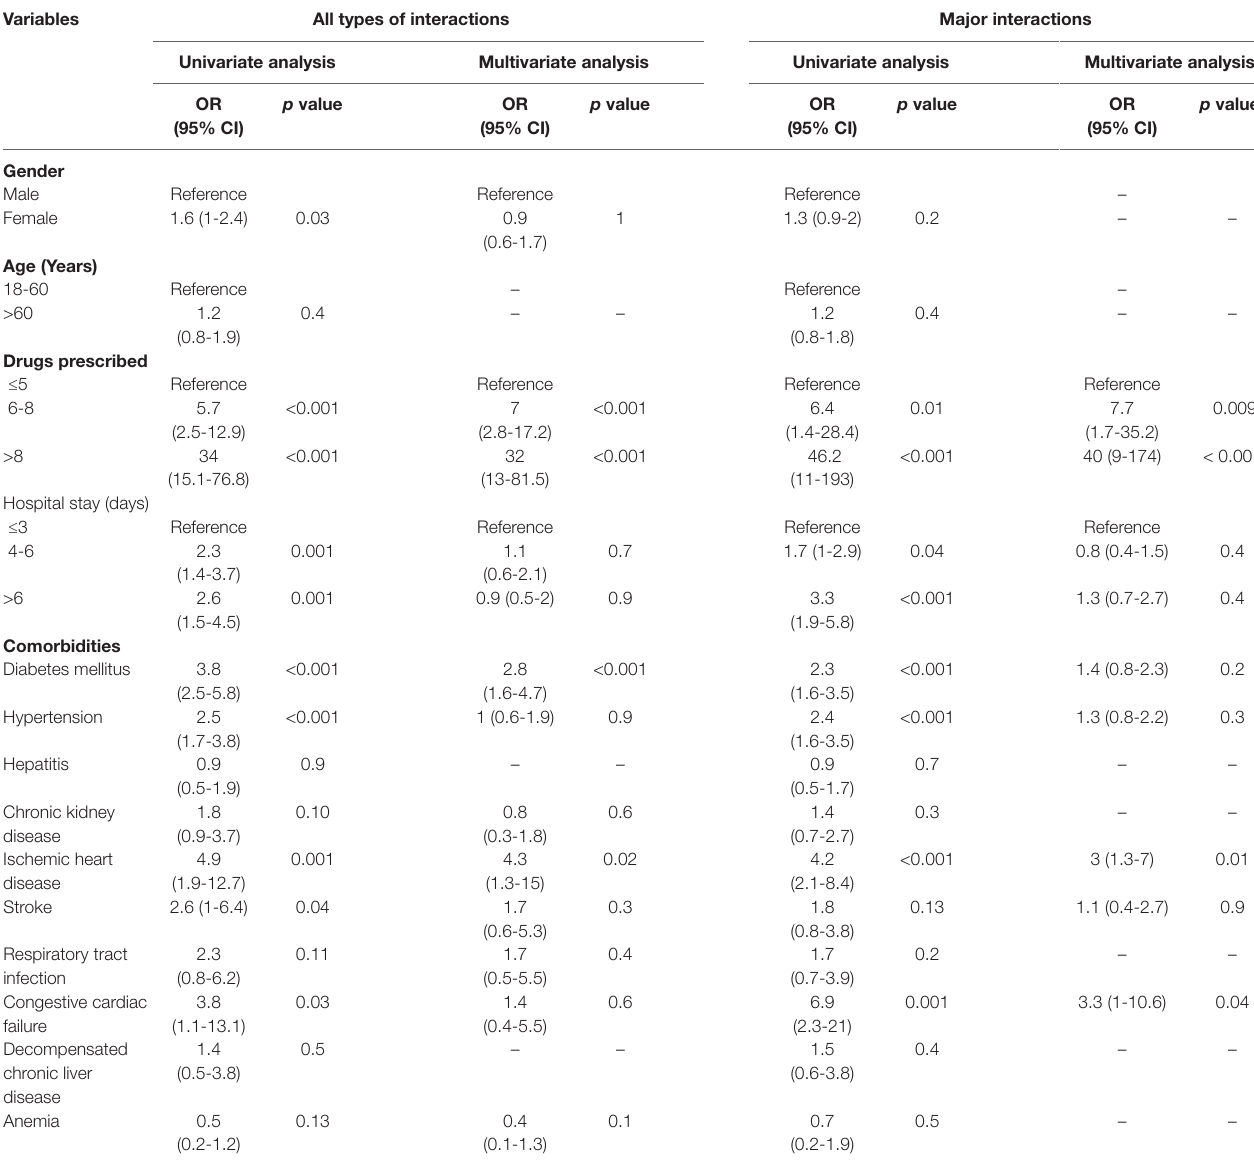
TABLE 2 | Logistic regression analysis based on exposure to all types and major interactions.